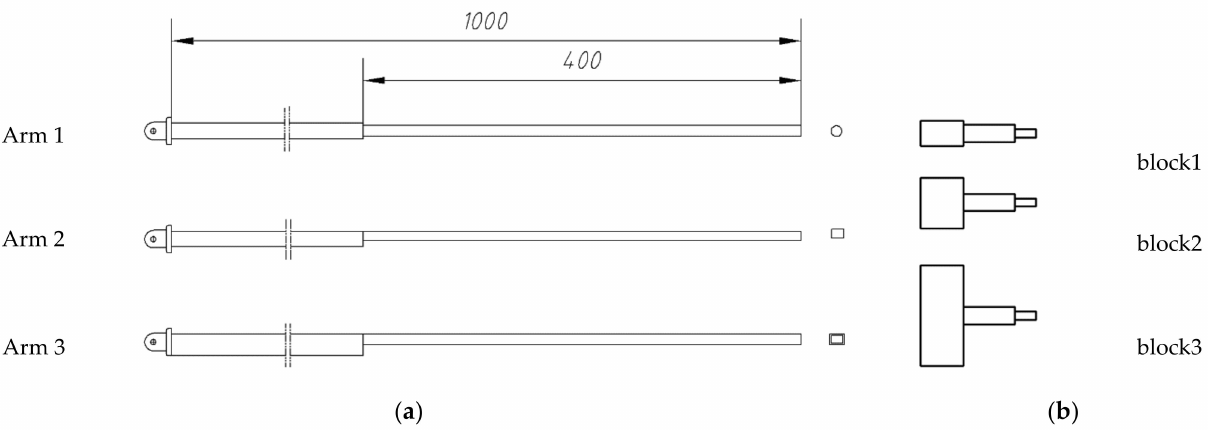
Figure 8. Models of flexible mechanical arms and quality blocks. ( a ) Mechanical arm structure. ( b ) Mass block structure.